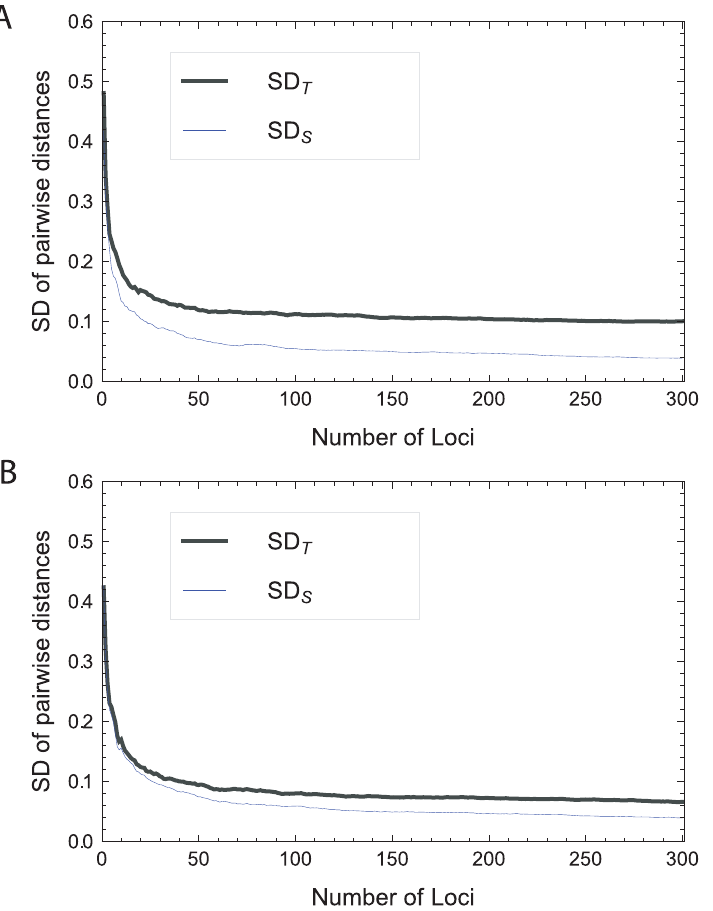
Fig 8. A simulation of SD T and SD S under a two panmictic population model demonstrating the divergent behavior of these two statistics with an increasing number of SNP loci. SNP frequencies are modeled on Beta distributions (as in [5]). (A) with F ST = 0.10. (B) with F ST =